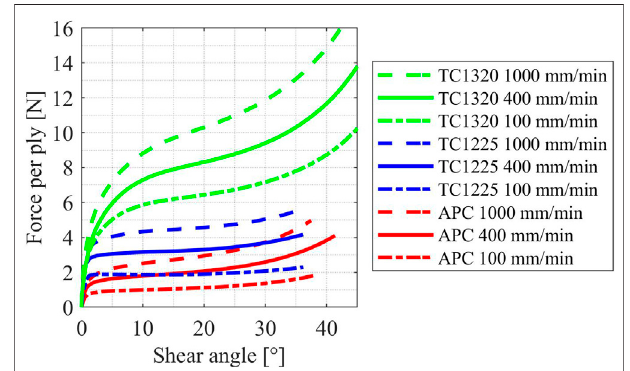
FIGURE 12 | Measurement data from this article on Solvay APC and Toray TC1225 at 365 ° C and specimen dimensions 170× 80 mm 2 ,compared to previous data from Brands et al. (2021) on Toray TC1320 UD/C/PEKK at 375 ° C and dimensions 180 × 80 mm 2 .